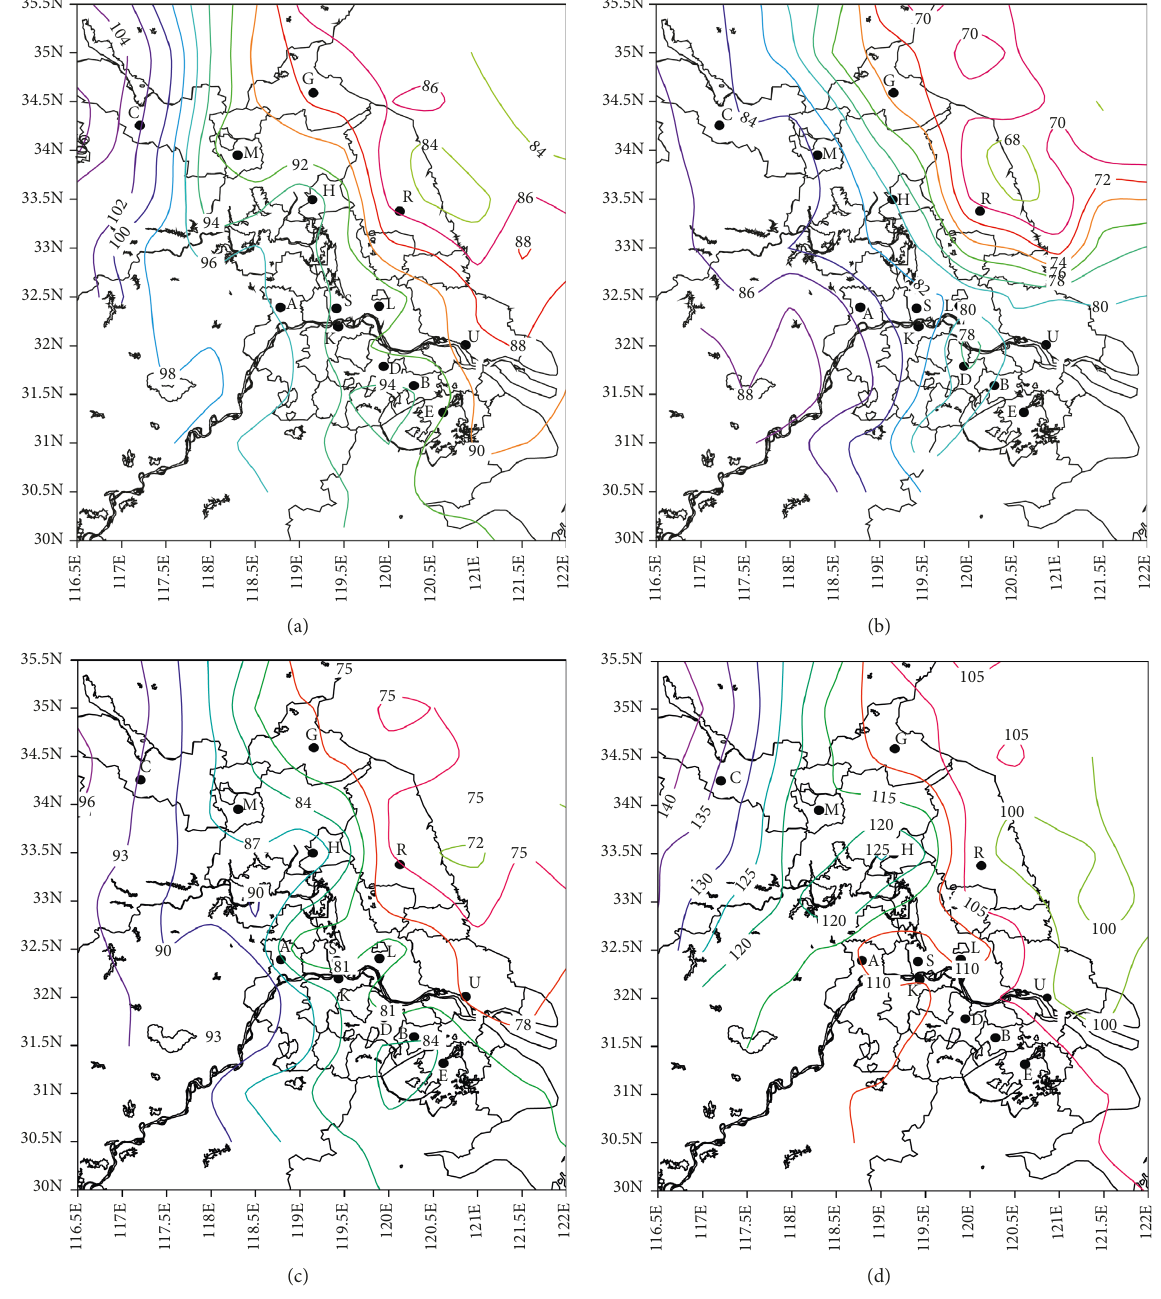
Figure 6: Seasonal distribution of AQI in the period 2013–2017: (a) spring, (b) summer, (c) fall, and (d)